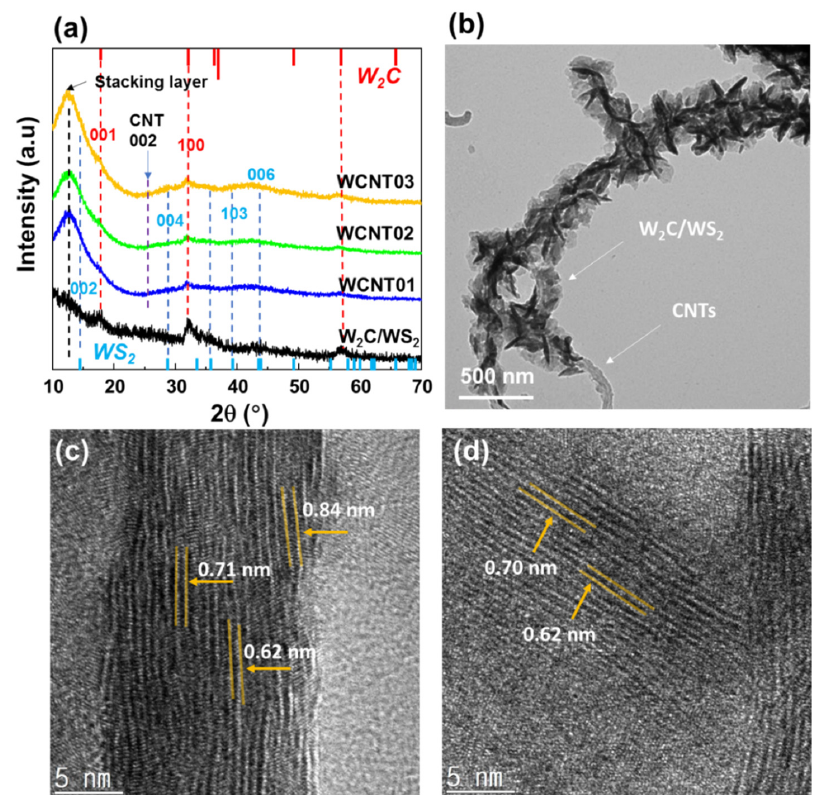
Figure 2. ( a ) XRD patterns of W 2 C/WS 2 and WCNT01/02/03; ( b ) TEM images and ( c , d ) high-resolution TEM (HR-TEM) images of WCNT01.